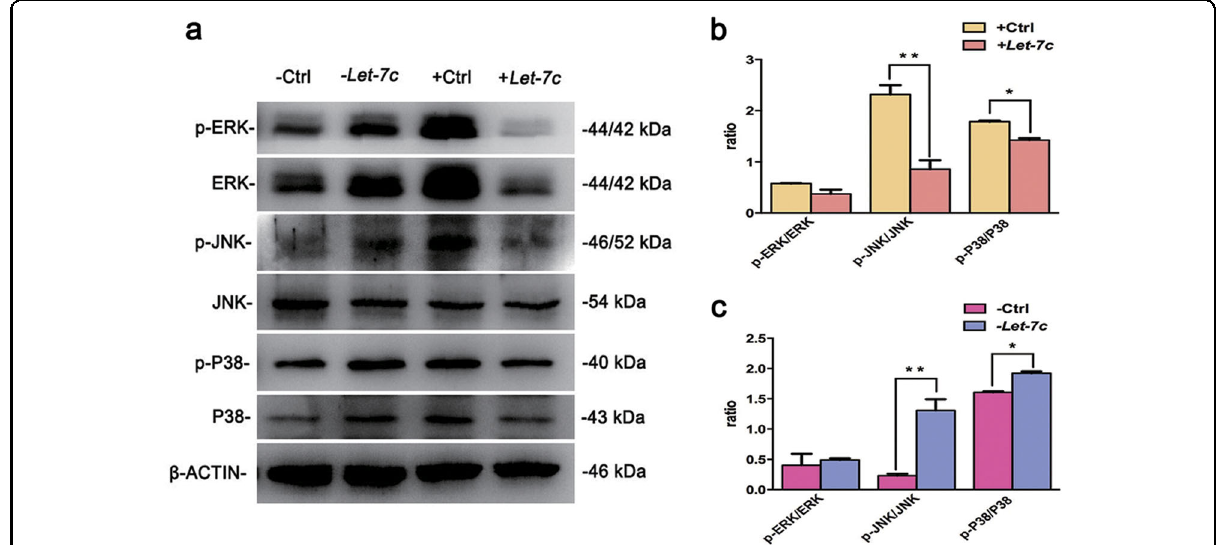
Fig. 6 Involvement of MAPK signaling pathways. a The expression of MAPK-related proteins (ERK, p-ERK, JNK, p-JNK, P38, and p-P38) was analyzed by Western blot in different groups. β -ACTIN served as the internal control. b Quantitative analysis demonstrated that the p-JNK/JNK and p-P38/P38 ratios were signi fi cantly decreased in + Let-7c DPMSCs compared to + Ctrl DPMSCs. c The p-JNK/JNK and p-P38/P38 ratios were signi fi cantly increased in − Let-7c DPMSCs compared to – Ctrl DPMSCs. Values are presented as the mean ± SD, n = 3. ** P < 0.01; * P <